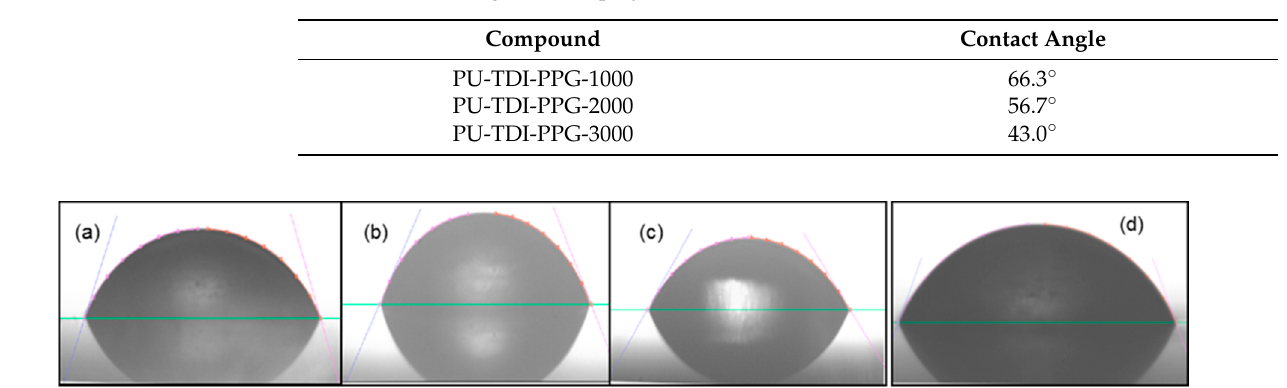
Figure 6. DSC thermogram of ( a ) blocked TDI, ( b ) PU-TDI-PPG-1000 (inset: two cycles), ( c ) PU-TDI-PPG-2000 and ( d ) PU- PPG-3000.